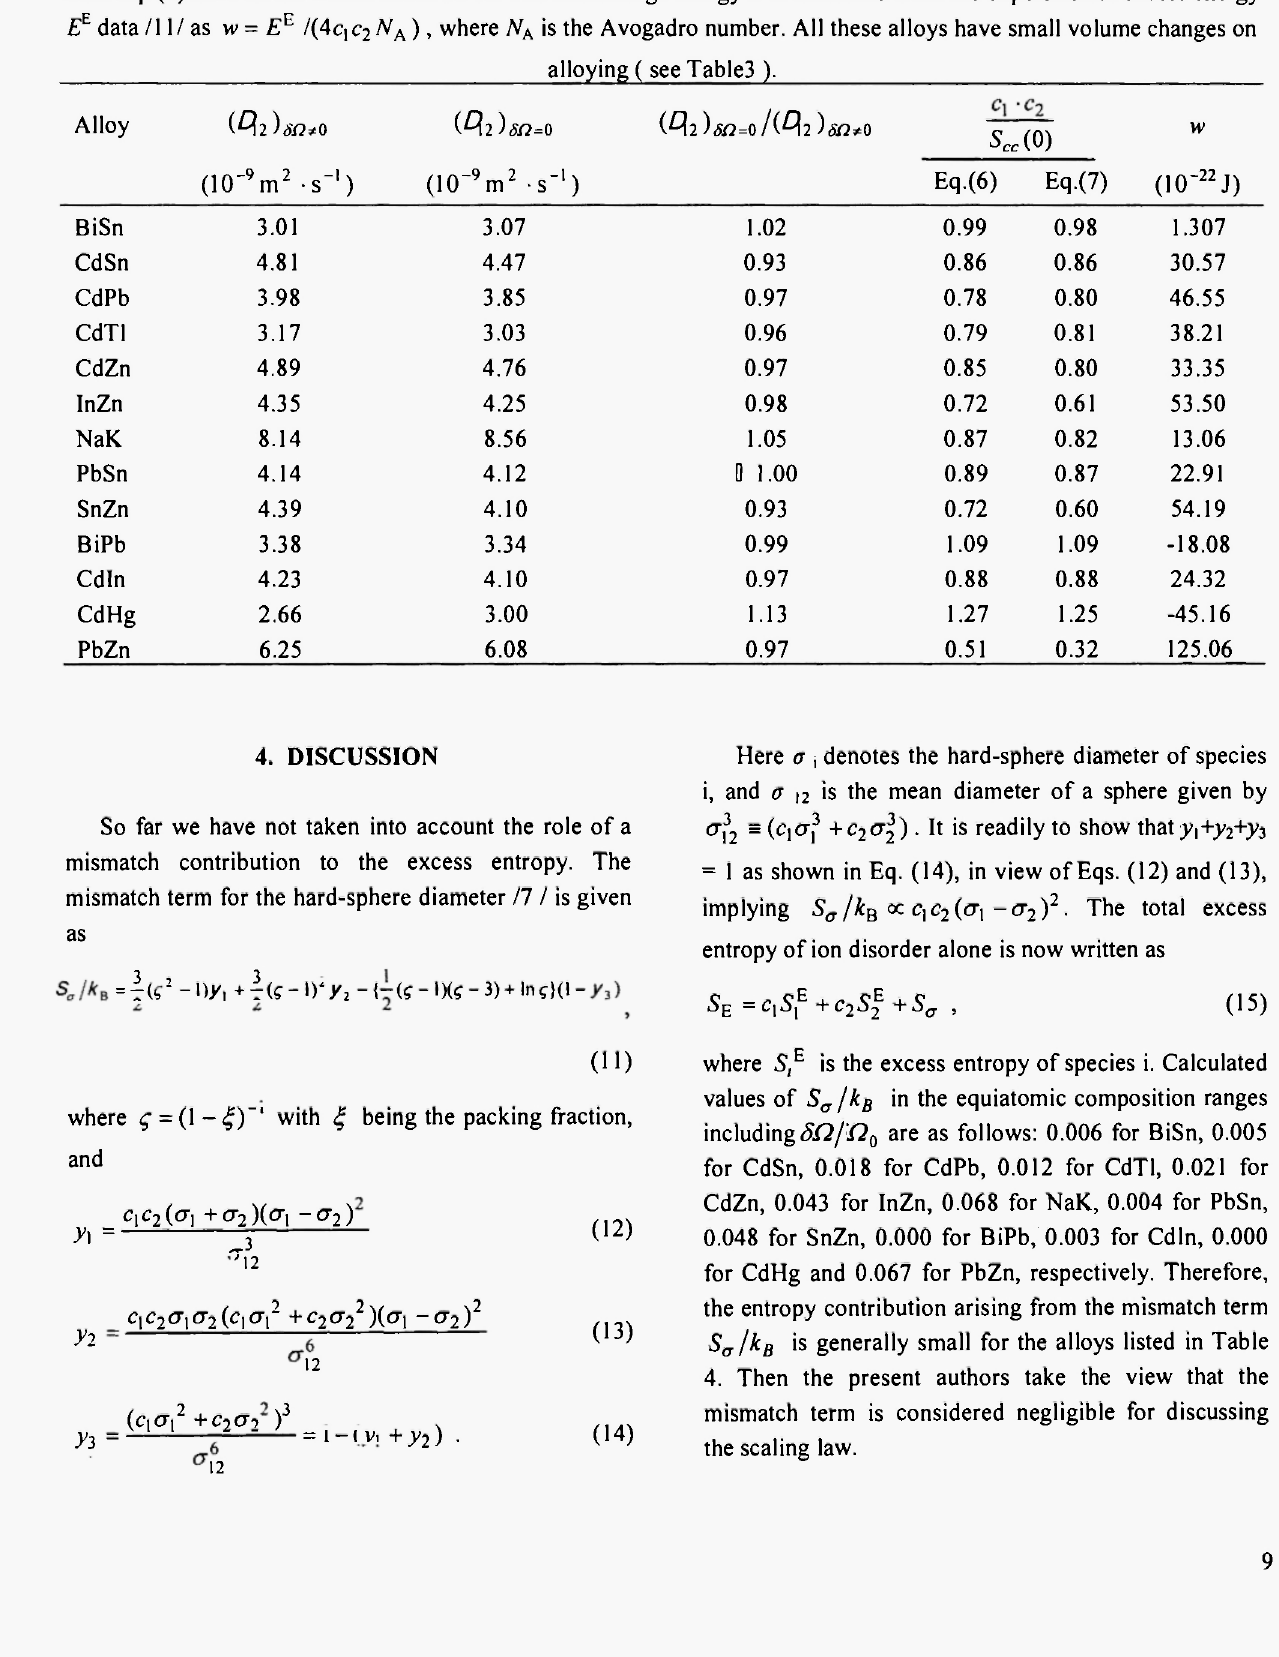
D 12 and S cc (0) of 13 alloys ( c, = c 2 = 0.5) with the same temperature given in Table 1. The values of D 12